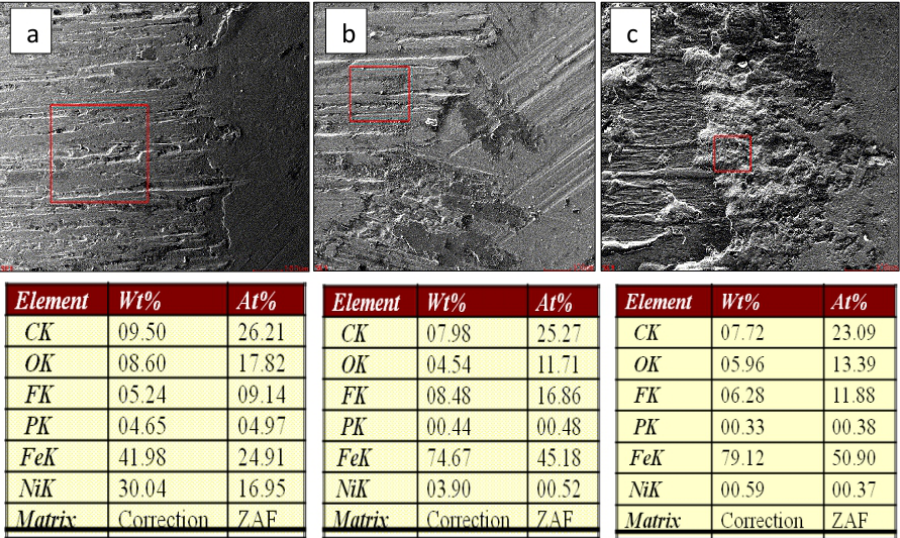
Figure 10. SEM/EDAX results of worn surface of the Ni-P-PTFE coating at (a) 10 N, (b) 20 N, (c) and 30 N